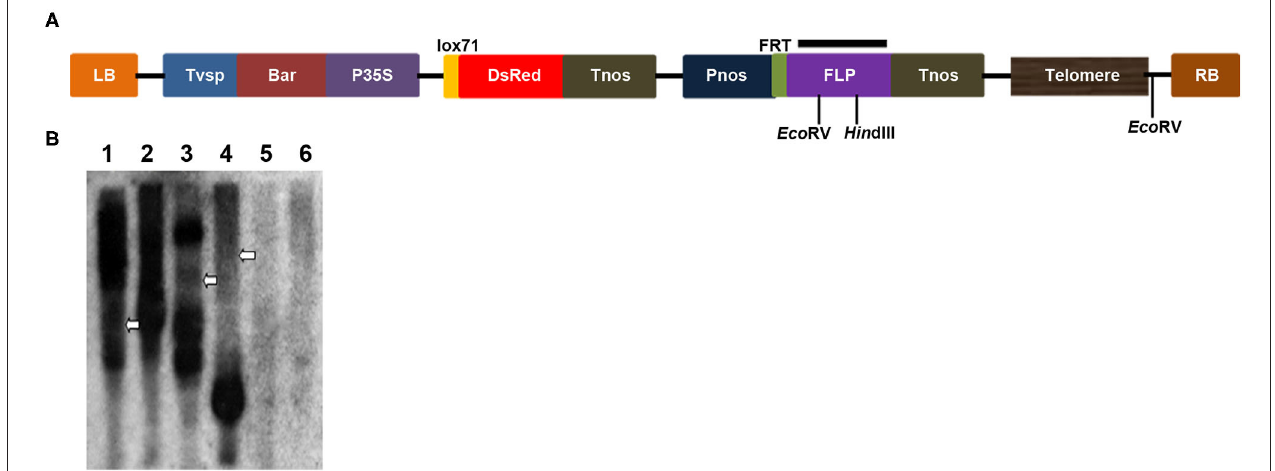
FIGURE 3 | Chromosomal truncations demonstrated by a Southern blot analysis with enzymatic digestions. (A) Scheme of the T-DNA region of the pWY86-1 construct with restriction sites used in DNA gel blot analysis. Black bar shows the region targeted by hybridizing FLP probes. (B) Restriction mapping of two transgenes 86-1-73 and 86-1-75 by a Southern blot. Genomic DNAs of lanes 1, 3, and 5 were digested with Hin dIII and lanes 2, 4, 6 digested with Eco RV, respectively. Genomic DNAs of lanes 1 and 2 were from 86-1-73, lanes 3 and 4 from 86-1-75, and lanes 5 and 6 from WT. The Southern blot was hybridized with the 32 P-labeled FLP probe. Telomere smears are indicated by